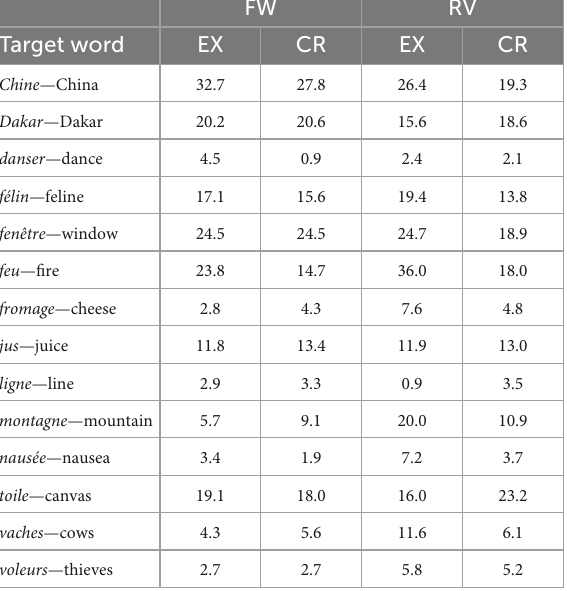
TABLE 6 Number of rebus resolutions, divided by the total number of times the target word appeared in each condition of each variation, presented as percentages (%RR), given by the naive participants to the target words in EX (experimental) and CR (control) conditions in, respectively, FW (forward) and RV (reverse)